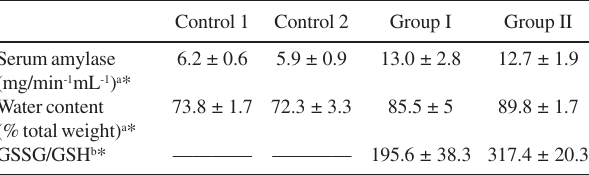
Table 1: Serum amylase, pancreas water content and GSSG/ GSH ratios in Controls and AP Groups